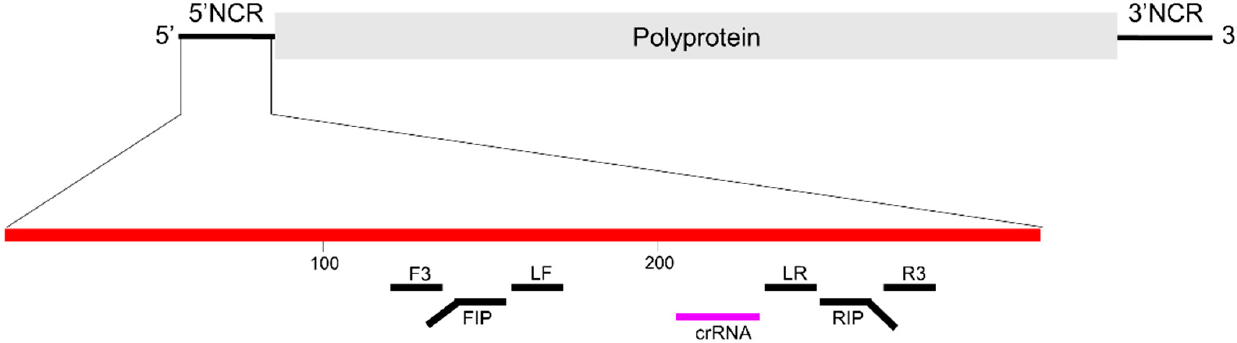
Figure 1. Overall workflow for RT-LAMP-coupled CRISPR–Cas12 assay. Extracted HCV RNA was amplified using RT-LAMP assay and the LAMP products was detected by CRISPR–Cas12 assay. Results were interpreted through lateral flow-based or fluorescence-based readouts. T, Test line; C, Control line; PAM, protospacer adjacent motif.